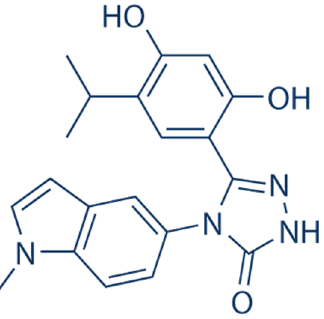
Figure 2. Chemical structure of ganetespib. Ganetespib, 5-[2,4-dihydroxy-5-(1 methylethyl)phenyl]-